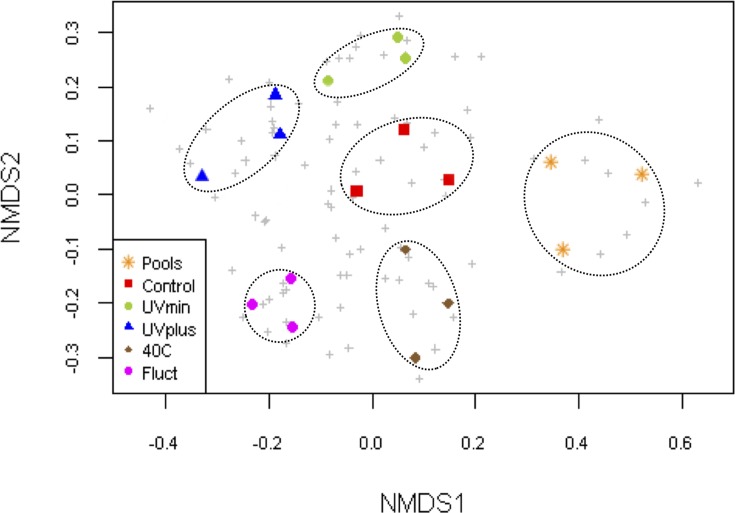
Non-metric multidimensional scaling (NMDS) ordination plot of Bray–Curtis community dissimilarities based on OTUs from the 16S rRNA gene sequences at the end of the experiment (2D stress value = 0.19).Color symbols represent the mesocosms from each treatment and pools, while grey crosses represent OTUs.